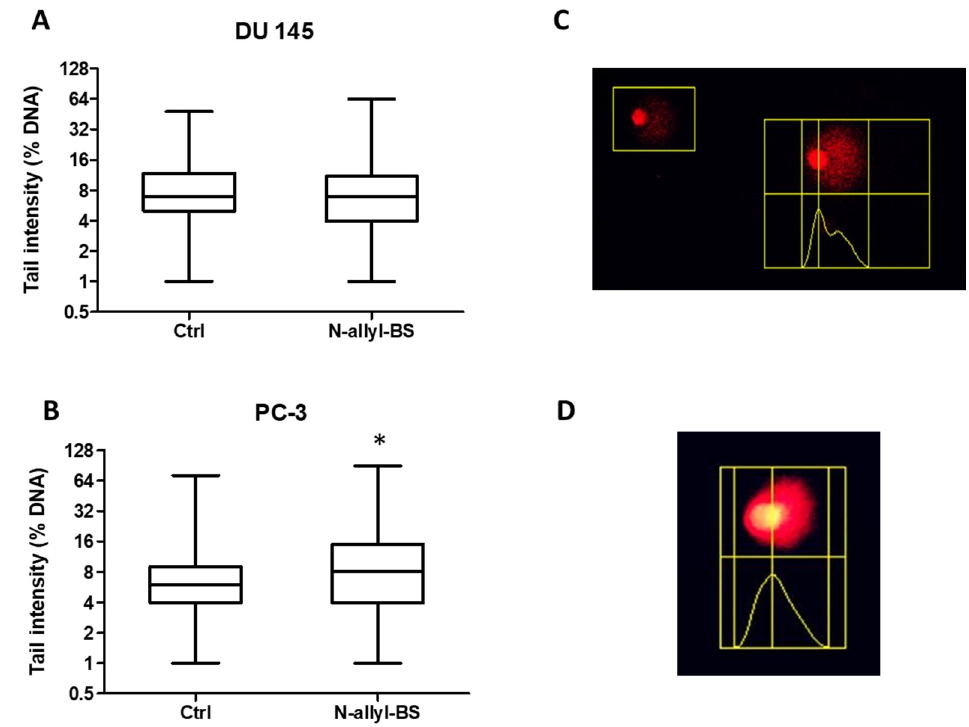
Figure 8. The influence of 40 μ M N- allyl-BS on DNA damage in DU 145 ( A ) and PC-3 ( B ) cells after 24h treatment was determined using comet assay. The results are presented asthe percentage of DNA in Tail Intensity ± SE (n = 3). Significance of differences compared with control was calculated by student T test. (*P < 0.05). Representative pictures of DU 145 ( C ) and PC-3 ( D ) cells in the upper 90th percentile of tail intensity.